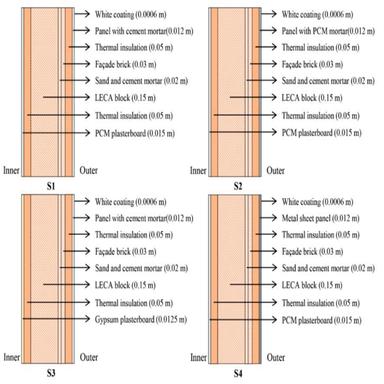
Proposed wall options for the existing south-facing facade with brick.